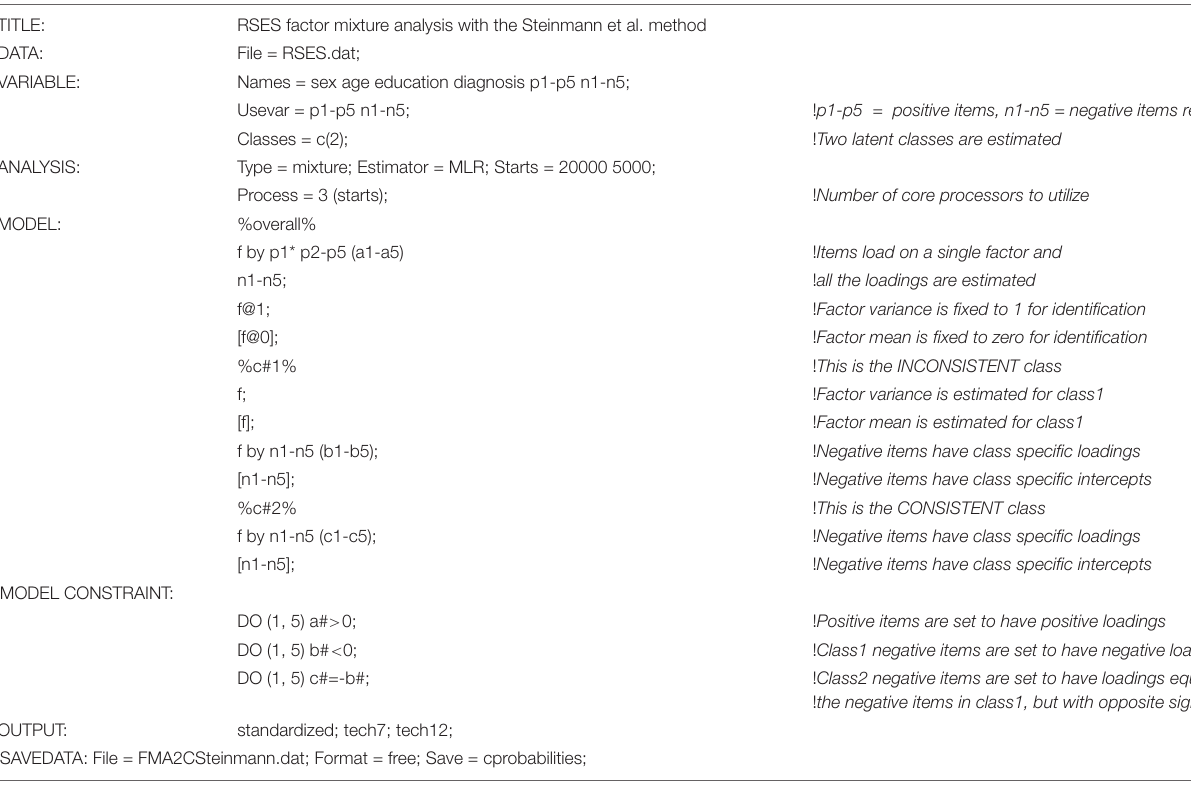
TABLE A1 | M plus Syntax for the Factor Mixture Analysis with the Steinmann et al. Method.